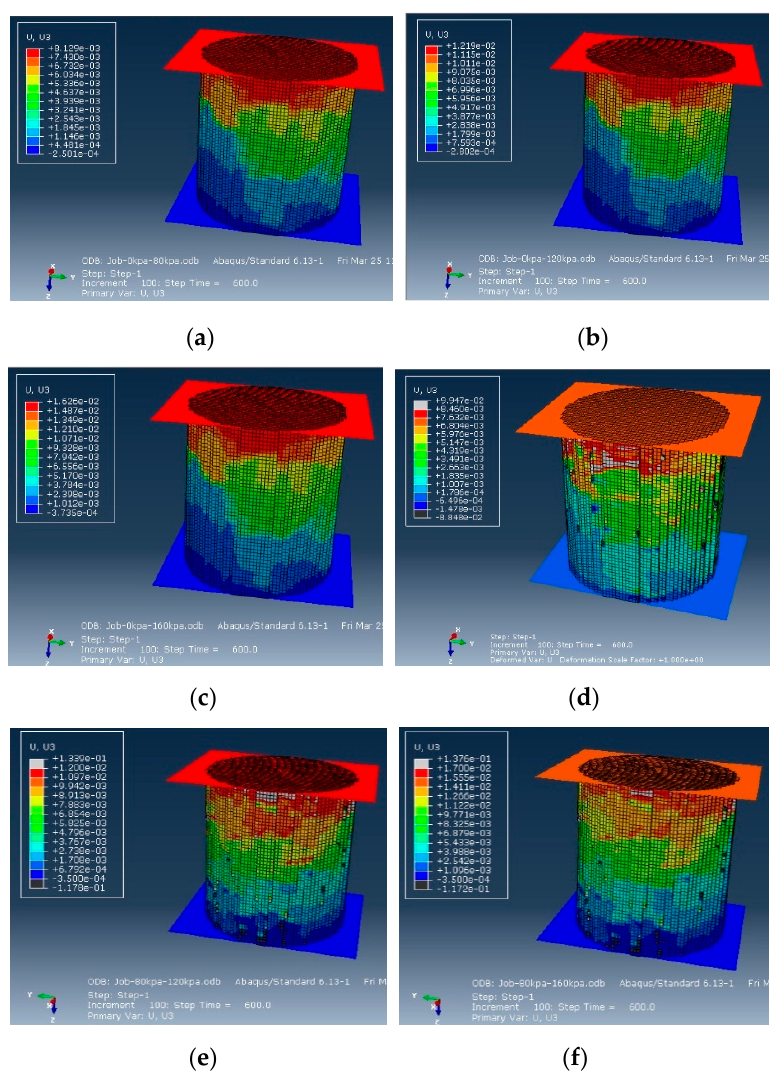
Figure 9. Creep deformation: ( a ) 80 kPa vertical load, without confining pressure; ( b ) 120 kPa vertical load, without confining pressure; ( c ) 160 kPa vertical load, without confining pressure; ( d ) 80 kPa vertical load, with 60 kPa confining pressure; ( e ) 120 kPa vertical load, with 60 kPa confining pressure; ( f ) 160 kPa vertical load, with 60 kPa confining pressure.